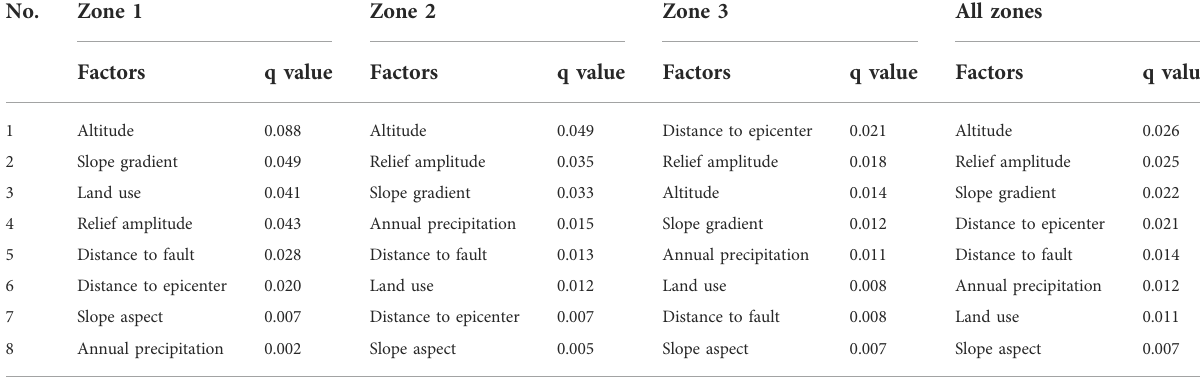
TABLE 2 Landslide controlling factors in different